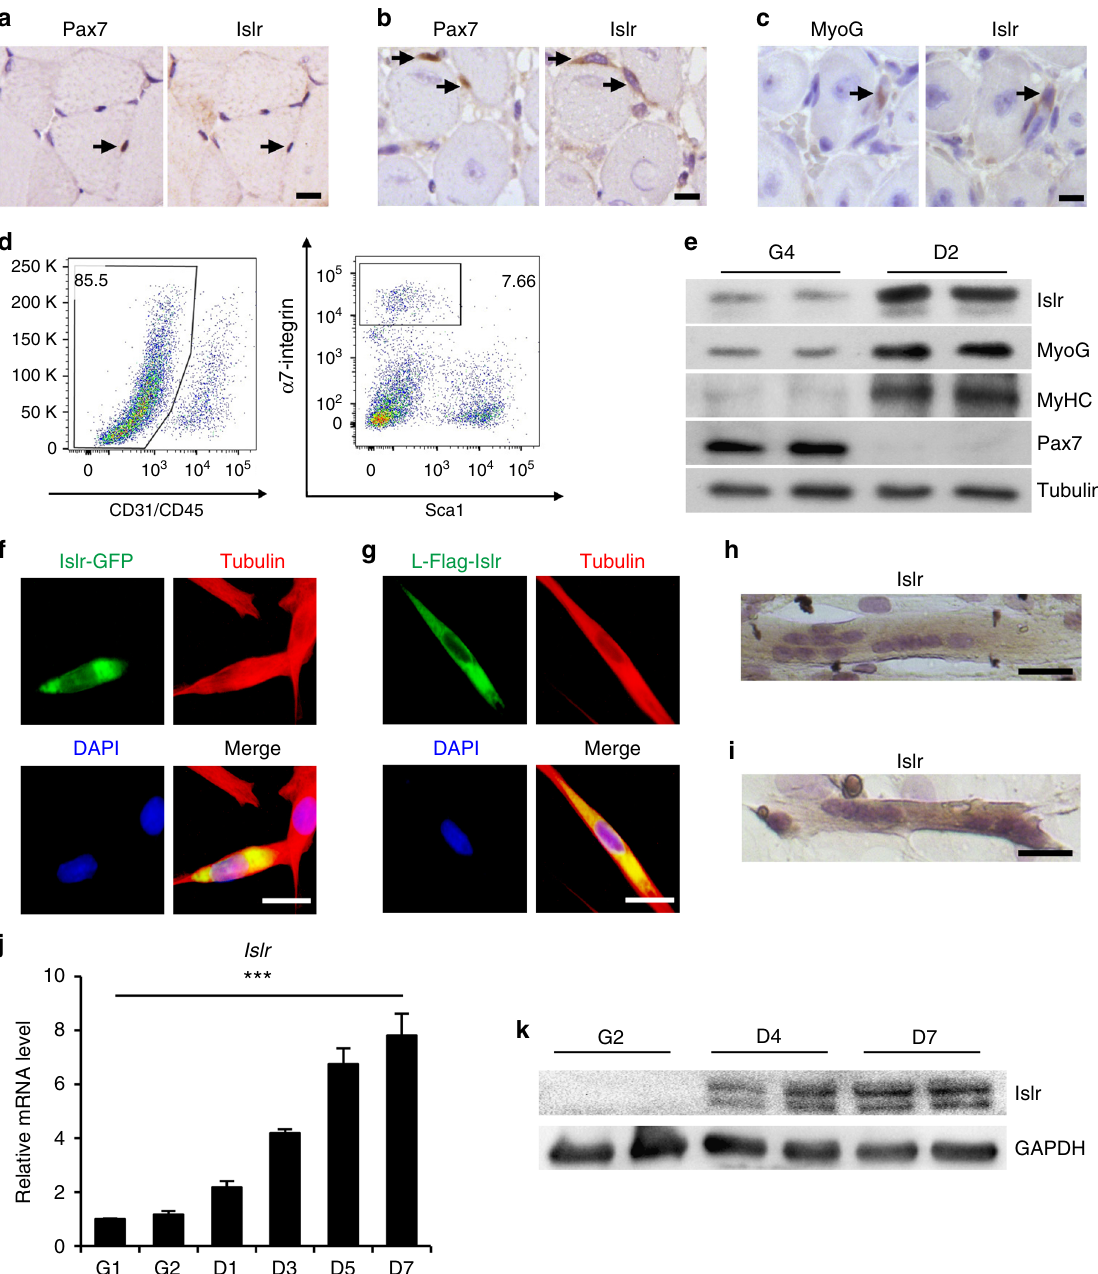
Fig. 1 Islr is upregulated during satellite cell differentiation and C2C12 differentiation. a Immunohistochemistry analysis of Islr and Pax7 in uninjured TA muscles of wild-type (WT) mice. Scale bar = 10 μ m. b Immunohistochemistry analysis of Islr and Pax7 in injured TA muscles of wild-type mice at 5